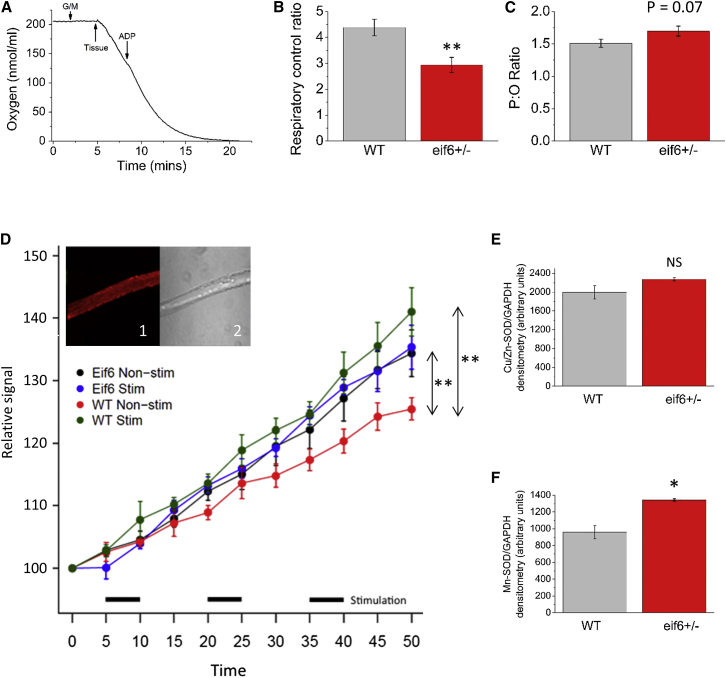
Respiration and ROS Generation in Eif6 Heterozygote Muscle(A) Typical oxygen utilization dynamics of muscle tissue before and after addition of ADP to the medium.(B) Respiratory control ratio (ratio of respiration state 3 to state 4) is significantly lower in Eif6+/− (n = 8) muscle compared with WT muscle (n = 8).(C) P:O ratio is not significantly altered in Eif6 heterozygous muscle.(D) Mitosox (405-nm) signal (superoxide abundance) over time in response to electrically stimulated contraction in WT and Eif6+/− FDB muscle fibers. Black bars indicate periods of stimulation. Repeated-measures p value: WT versus WT stimulated, p = 0.0016, Eif6+/− versus Eif6+/− stimulated, p = 0.38, WT versus Eif6+/− non-stimulated, p < 0.01.(E and F) SOD1 (E) and SOD2 (F) protein expression measured by western blot in Eif6+/− muscle.Data are represented as mean ± SEM. ∗p < 0.05, ∗∗p < 0.01.